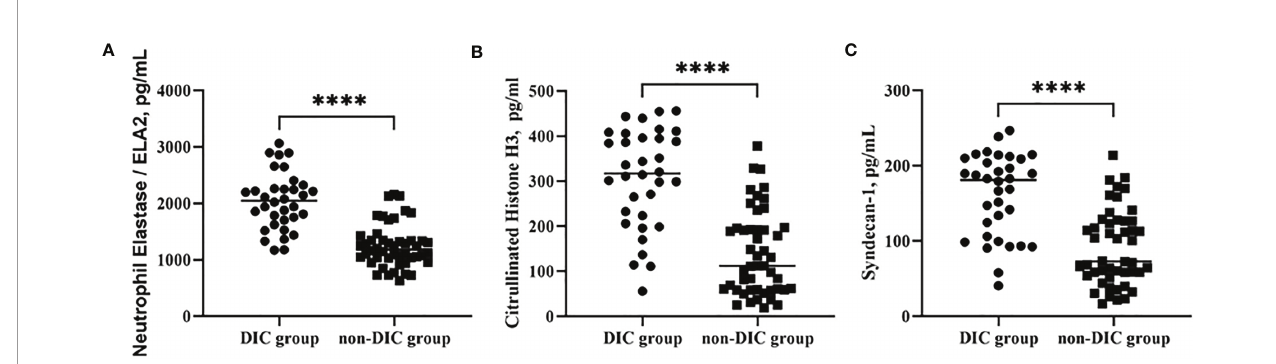
FIGURE 2 | Comparison of NET levels, including ELA2 (A) and H3 (B) , and syndecan-1 (C) in groups of patients with or without DIC. ****p < 0.0001. NETs, neutrophil extracellular traps; DIC, disseminated intravascular coagulation.